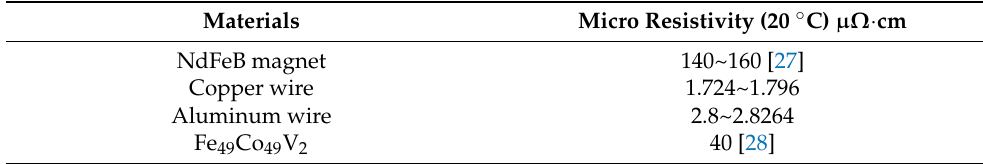
Table 1. Differential resistance of NdFeB, Fe 49 Co 49 V 2 , and ordinary wires.